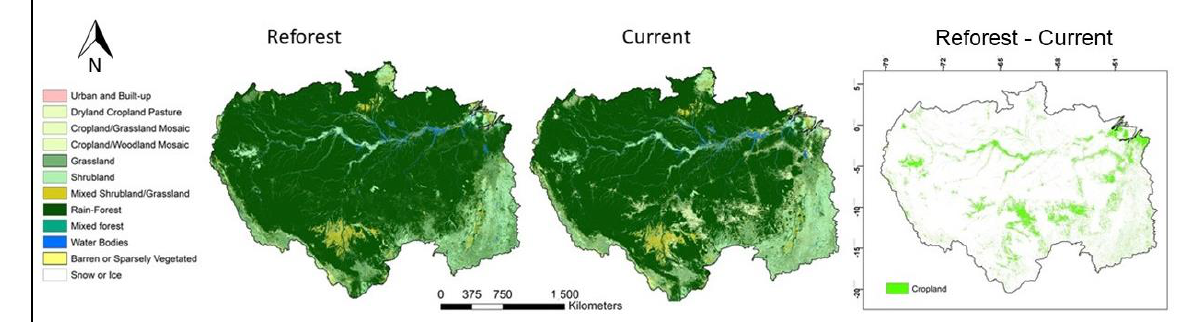
Figure 2. ESA land covers that were used in the simulation. In the Reforest map, all croplands are replaced by evergreen broadleaf forests. The highlighted areas on the difference map (right image) indicate reforested regions.